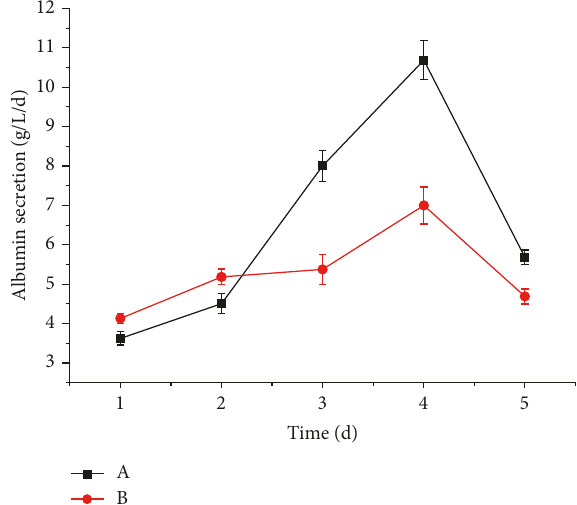
Figure 10: Albumin secretion by human hepatocytes cultured on biocarriers (A) and conventional media (B).